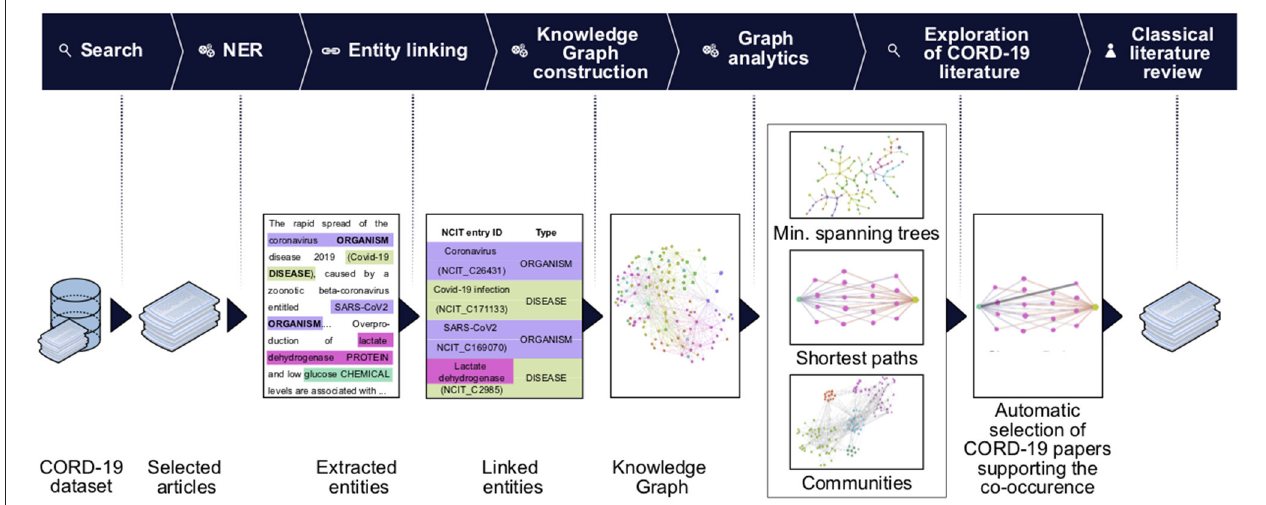
FIGURE 1 | Knowledge graph construction and analysis pipeline. Entities of interest are extracted using the named entities recognition (NER) techniques on the entire CORD-19 dataset, or on a subset of articles selected for matching user-specified query (Search). The extracted entities are then linked to the NCIT ontology terms and passed to the knowledge graph construction stage. On this stage we build a knowledge graph using extracted and linked terms as nodes and their co-occurrences as edges. The association strength between terms is quantified using a mutual-information based score of their co-occurrences. We perform various graph analytics tasks (e.g., community detection, BMIPs, minimum spanning trees computation) that allow us to navigate the knowledge graph and reveal connectivity patterns and subgraphs carrying the most important terms and their co-occurrences. Data from the graphs are then used to guide further literature review: a first seed set of article was obtained from the CORD-19, examining the articles featuring co-occurrence of terms of interest (first automatic selection of CORD-19 articles). Guided by this set of articles, we then perform a second step of classical literature review and consider other sources, not included in CORD-19 (see detailed description of the steps in section